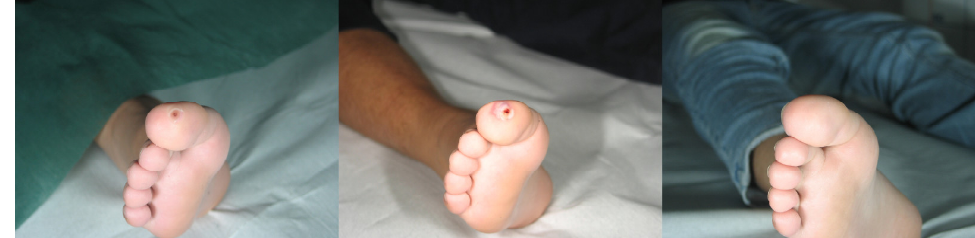
Figure 2. ( b ) Patient n. 20 before treatment (left) and 1 month after treatment (right) dermatoscopic view; ( a ) patient n. 20 before treatment (left) and 1 month after treatment (right).